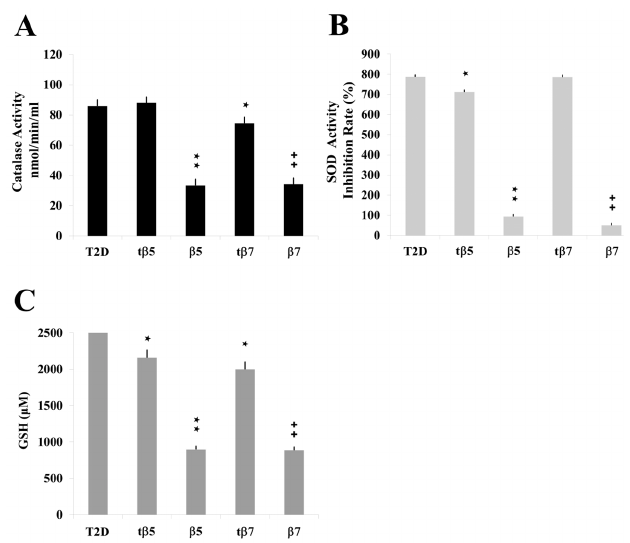
Figure 5. Effect of NLL β 5 and β 7 conglutins on CAT and SOD activities and GSH production in Type II diabetes (T2D) culture cells. CAT ( A ) and SOD ( B ) activities and GSH production ( C ). (cid:70) p < 0.05 T2D vs. t β 5 or t β 7; (cid:70)(cid:70) p < 0.05 β 5 vs. T2D; ++ p < 0.05 β 7 vs. T2D. Data represent mean ± SD from three independent